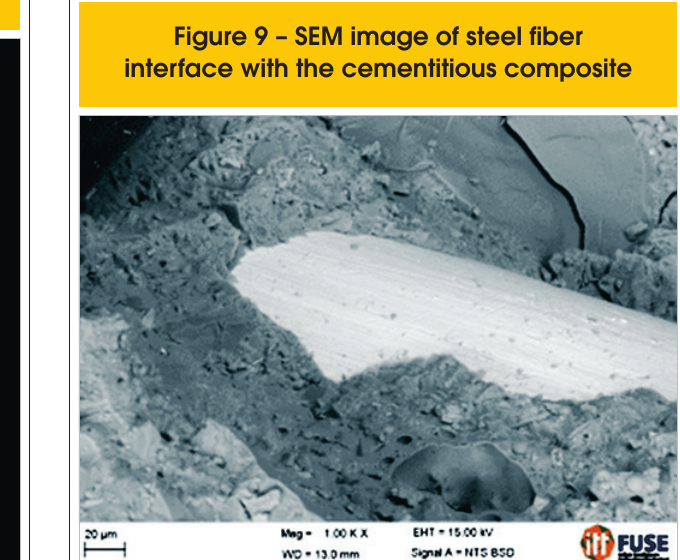
Figure 9 – SEM image of steel fiber interface with the cementitious